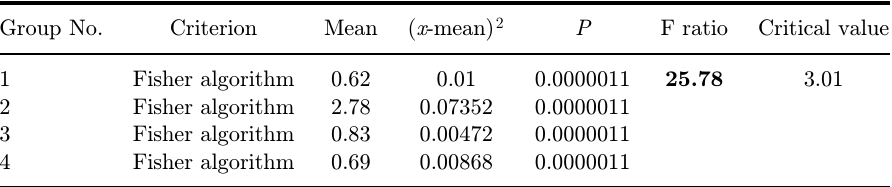
Table 5. ANOVA statistics for four di®erent arm movements on biceps muscle. Group No.